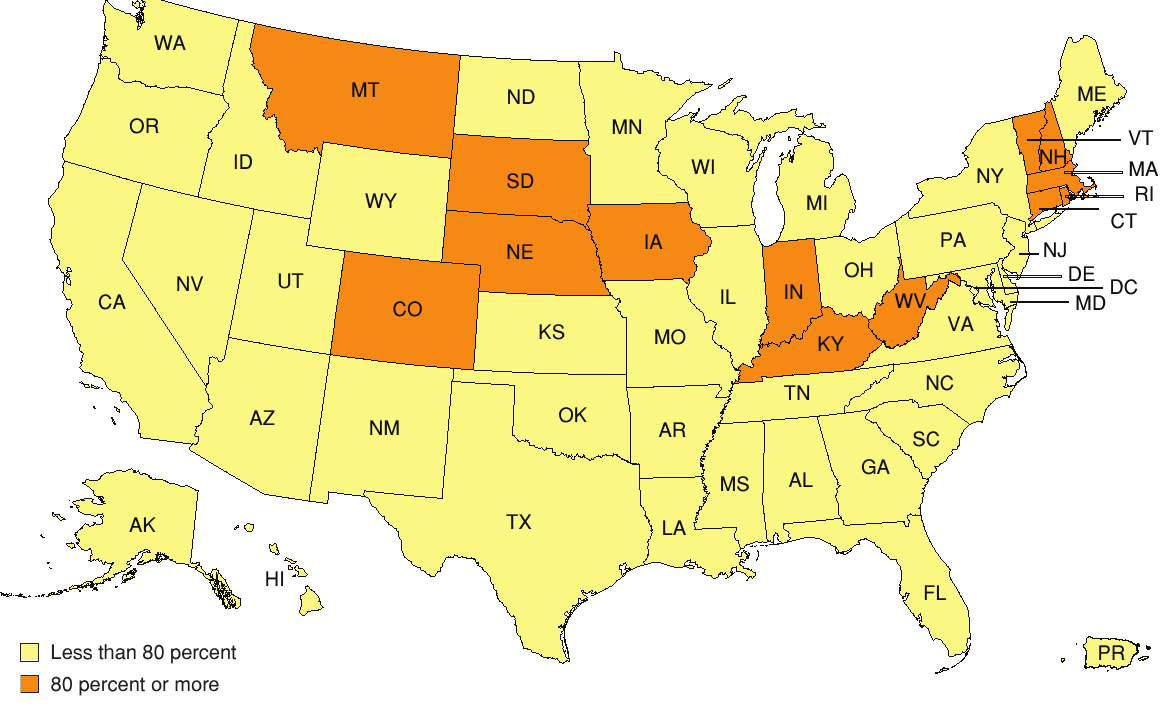
Figure 9. States in which 80 percent or more of all mental health treatment facilities were operated by private non-profit organizations: